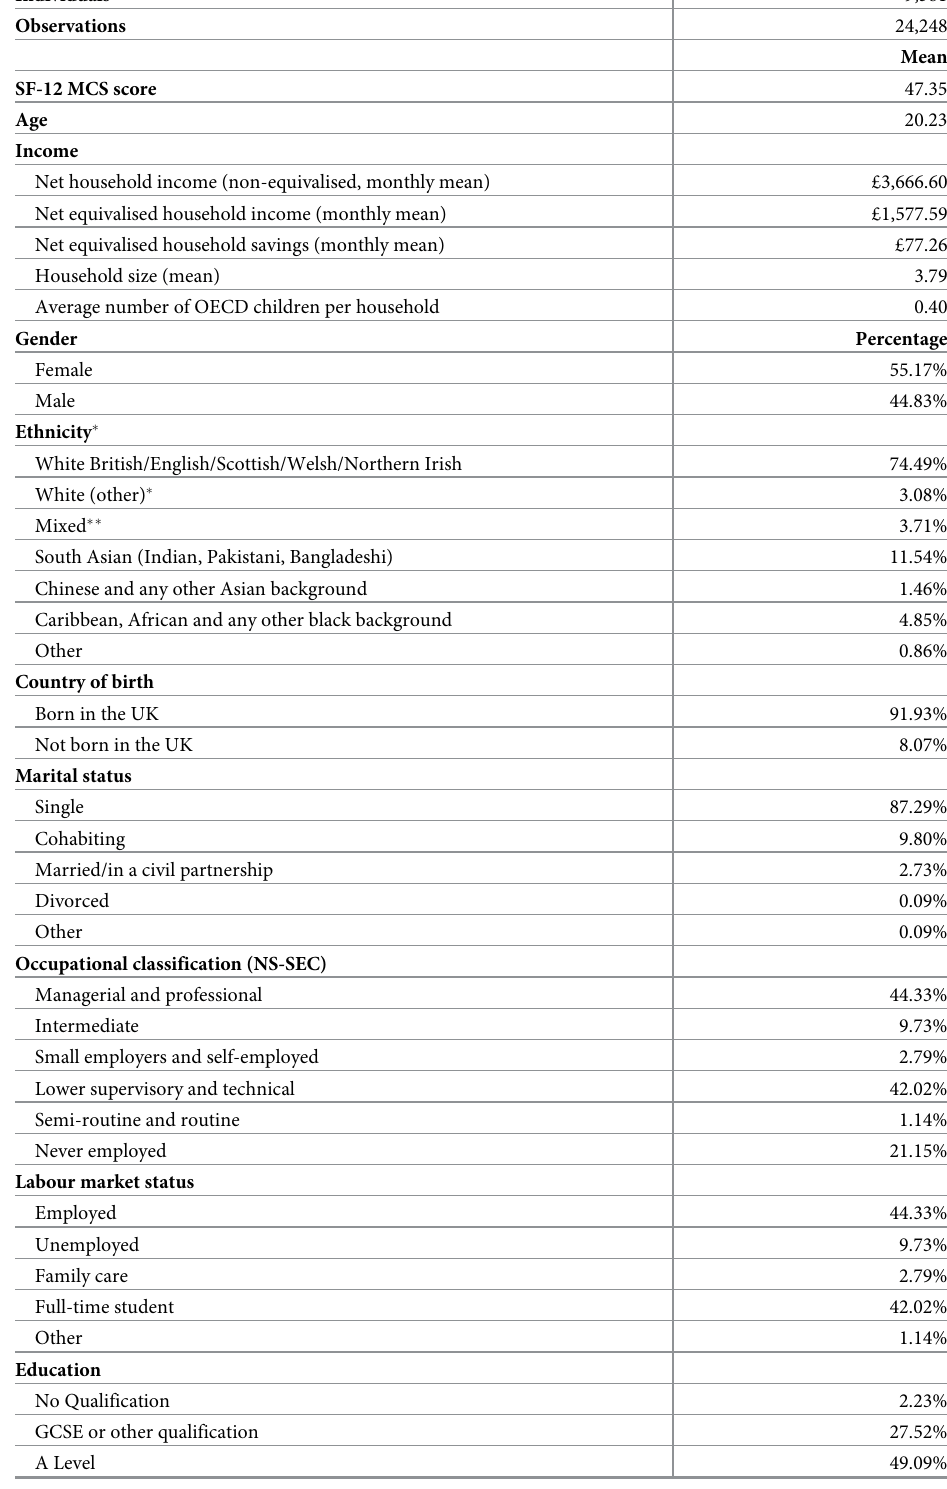
Table 1. Descriptive statistics for Understanding Society 16–24 SF-12 Mental Component Summary